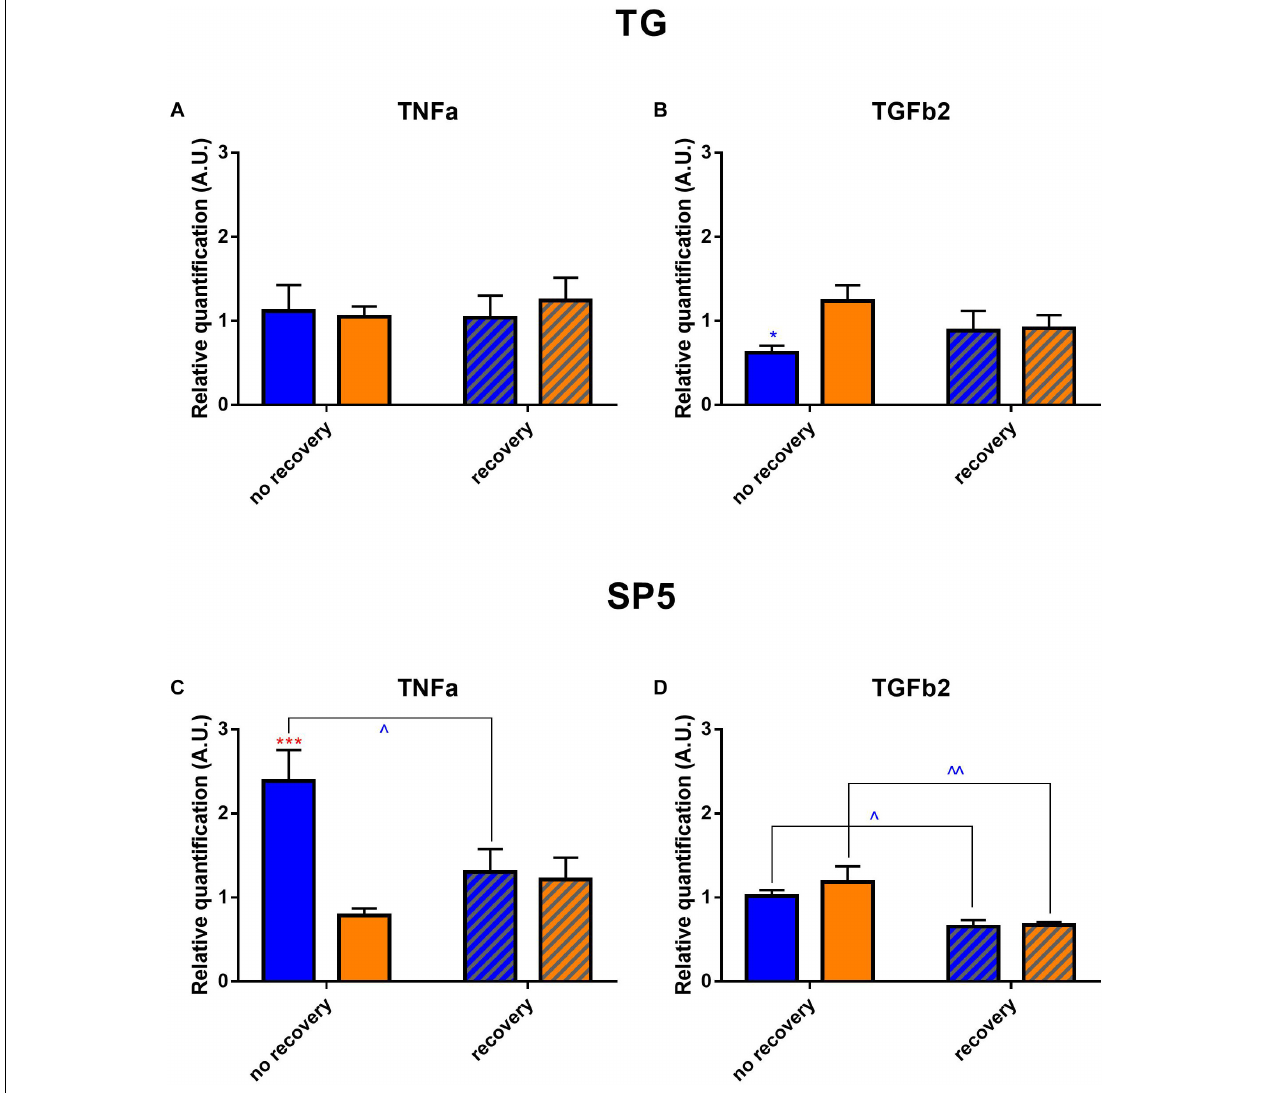
FIGURE 11 | Cytokine profile in trigeminal pathways. Results of mRNA expression of TGF β 2 and TNF α on the TGs (A,B) and brainstems (C,D) . Statistical significance for the TG: TGF β 2 blue no recovery vs. recovery – q = 0.0187, p = 0.0178. Statistical significance for the brainstem; TGF β 2: blue no recovery vs. recovery – q = 0.0169, p = 0.0161; yellow no recovery vs. recovery – q = 0.0041, p = 0.0020; TNF α : blue no recovery vs. recovery – q = 0.0197, p = 0.0188; recovery blue vs. yellow – q = 0.0005, p = 0.0005. Blue and yellow bars correspond to blue and yellow exposures, respectively; clear and hatched bars correspond to the time points of dissection, either directly after illumination (no recovery) or in 3 days of recovery (recovery), respectively. All the data are presented as mean ± SEM. Differences were considered significant when p < 0.05 ( ∗ / ∧ ), p < 0.01 ( ∗∗ / ∧∧ ), p < 0.001 ( ∗∗∗ / ∧∧∧ ) or p < 0.0001 ( ∗∗∗∗ / ∧∧∧∧ ). Stars correspond to comparisons between blue-illuminated and yellow-illuminated mice, treated with the same drug. Carets correspond to comparison of mice assessed directly after illumination to the ones assessed after 3 days of recovery, within the same spectra. Red color means increase and blue color decrease in